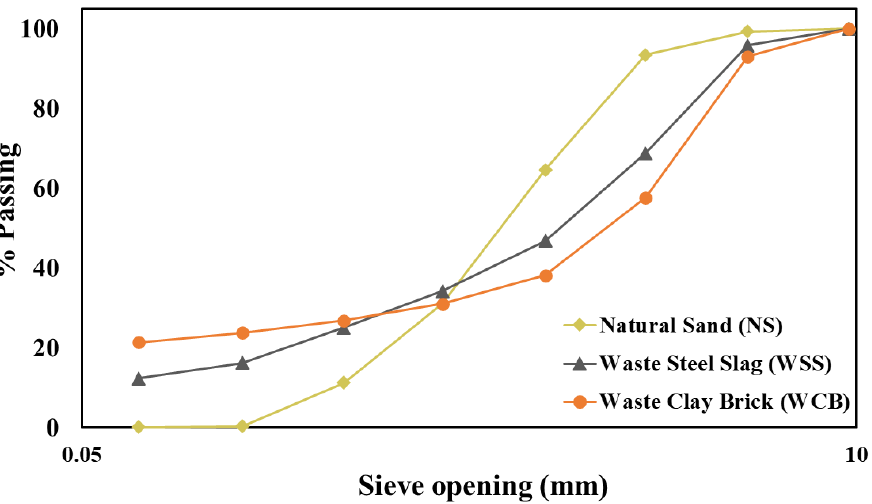
Figure 2. Grading curves of natural sand—NS, waste steel slag—WSS and waste clay brick—WCB. The specific gravity, absorption capacity and unit weight of the materials were tested as per ASTM C128 [25] and ASTM C 29 [26] standards. The specific gravity, absorption capacity and unit weight were, respectively, 2.56%, 5.86% and 1598.30 kg/m 3 for NS,